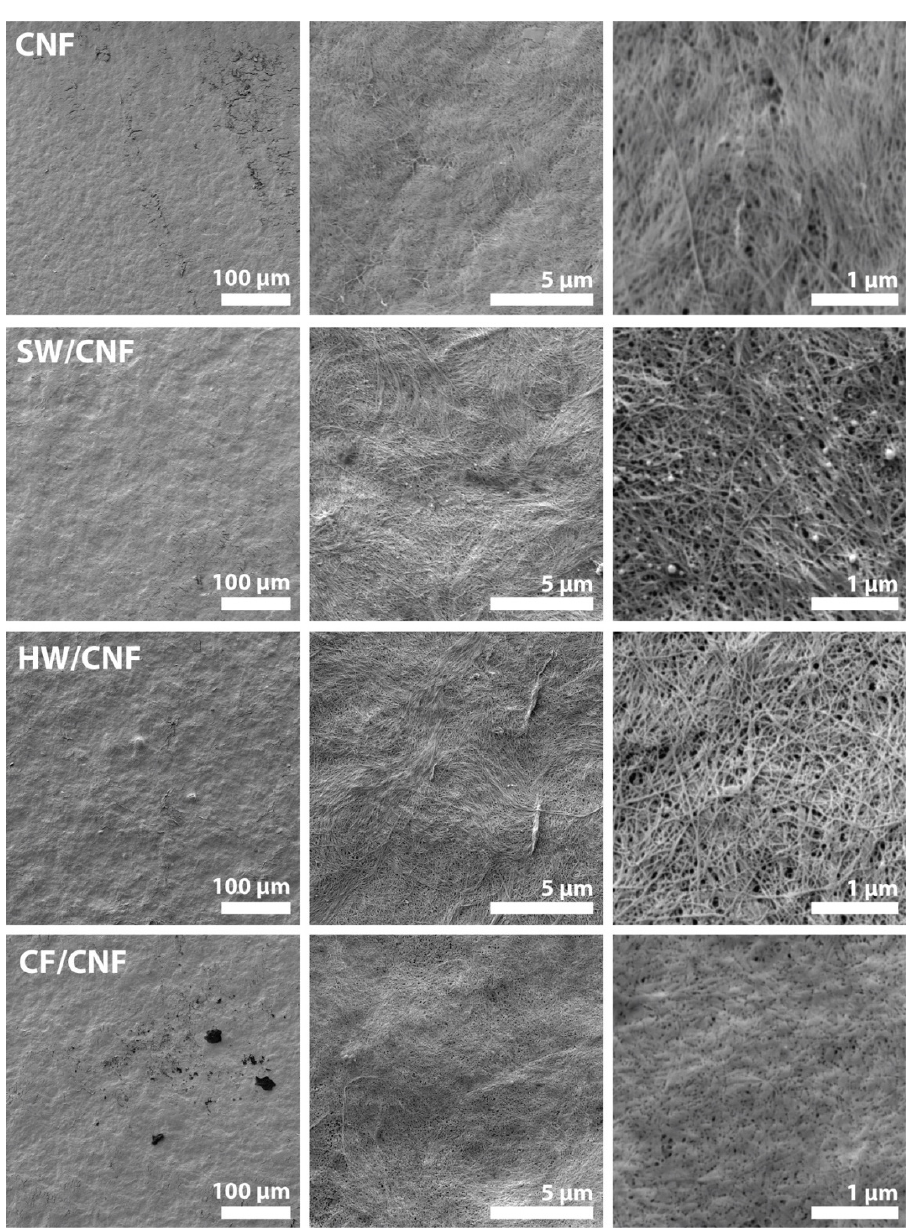
Figure 3. SEM images of surfaces of composite membranes at different magnifications (row 1: CNF, row 2: SW/CNF, row 3: HW/CNF, row 4: CF/CNF).